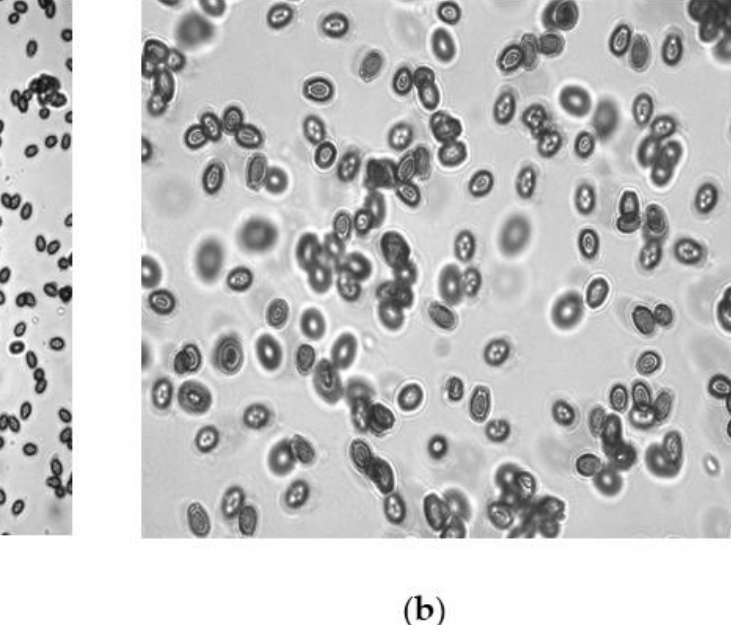
Figure 2. Inverted fluorescence microscope micrograph of basidiospores of G. lucidum at 40 × and 100 × . ( a ) 40 × shows small, brown and ovoid basidiospores of G. lucidum ( b ) 100 × shows that basidiospores appeared ovoid, truncated at the apex, with a dark brown eusporium bearing thick echinulae, surrounded by a hyaline myxosporium.